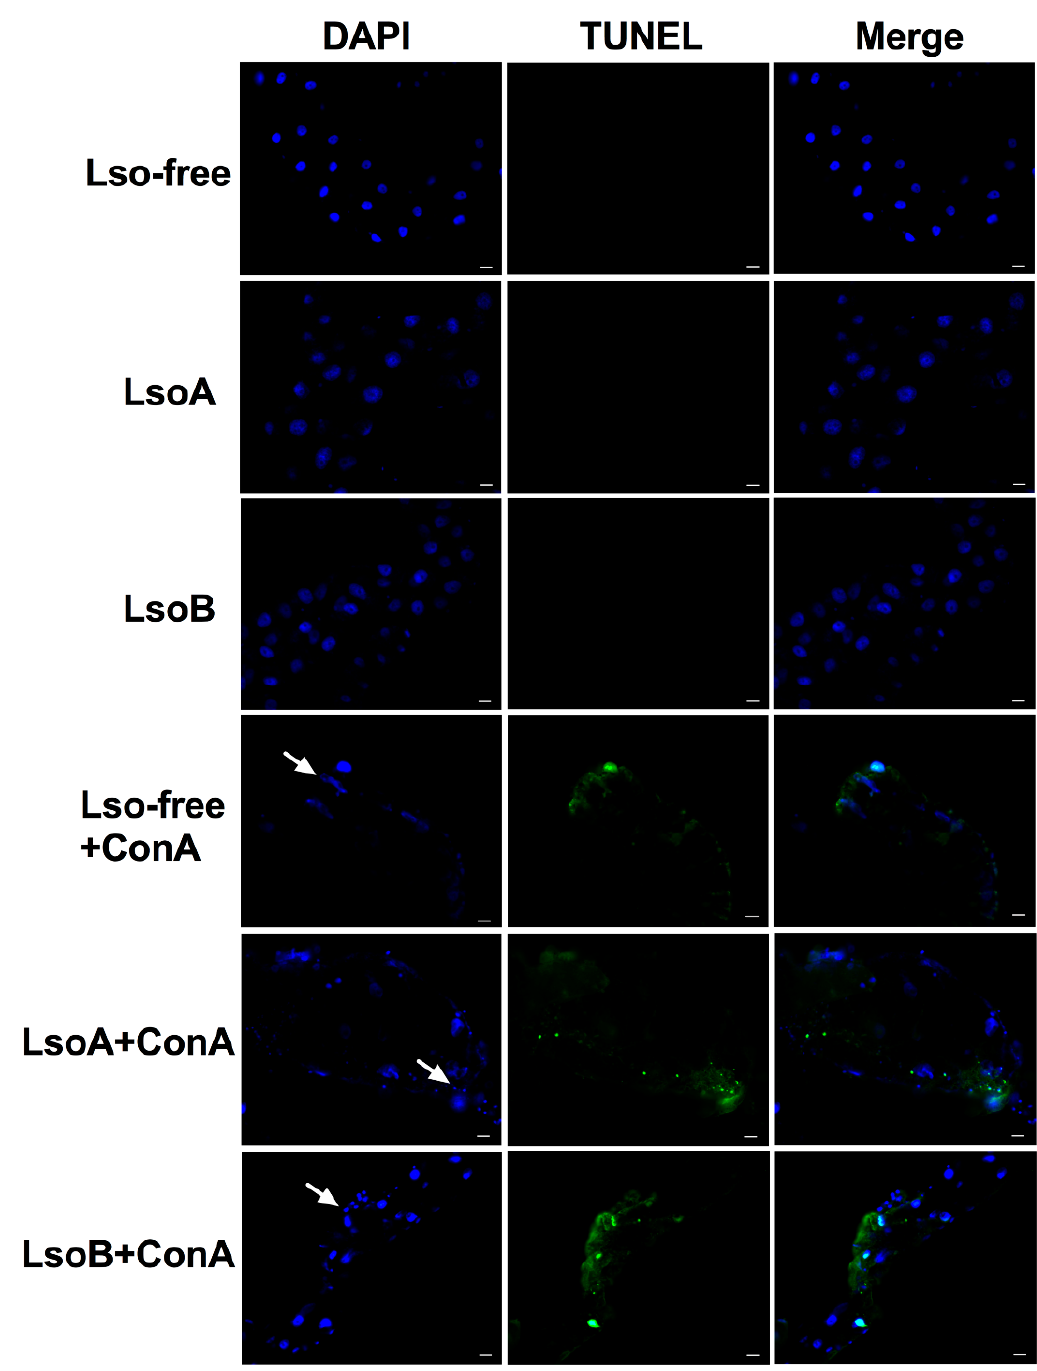
Figure 3. ConA induced apoptosis in the gut of Lso-free, LsoA-, and LsoB-infected potato psyllid. The tissues were stained using TUNEL assays to detect the apoptotic signals (green) and counterstained with DAPI to show the nuclei (blue) of the gut cells. The white arrows indicate the apoptotic nuclei. Scale bar is 20 μ m.